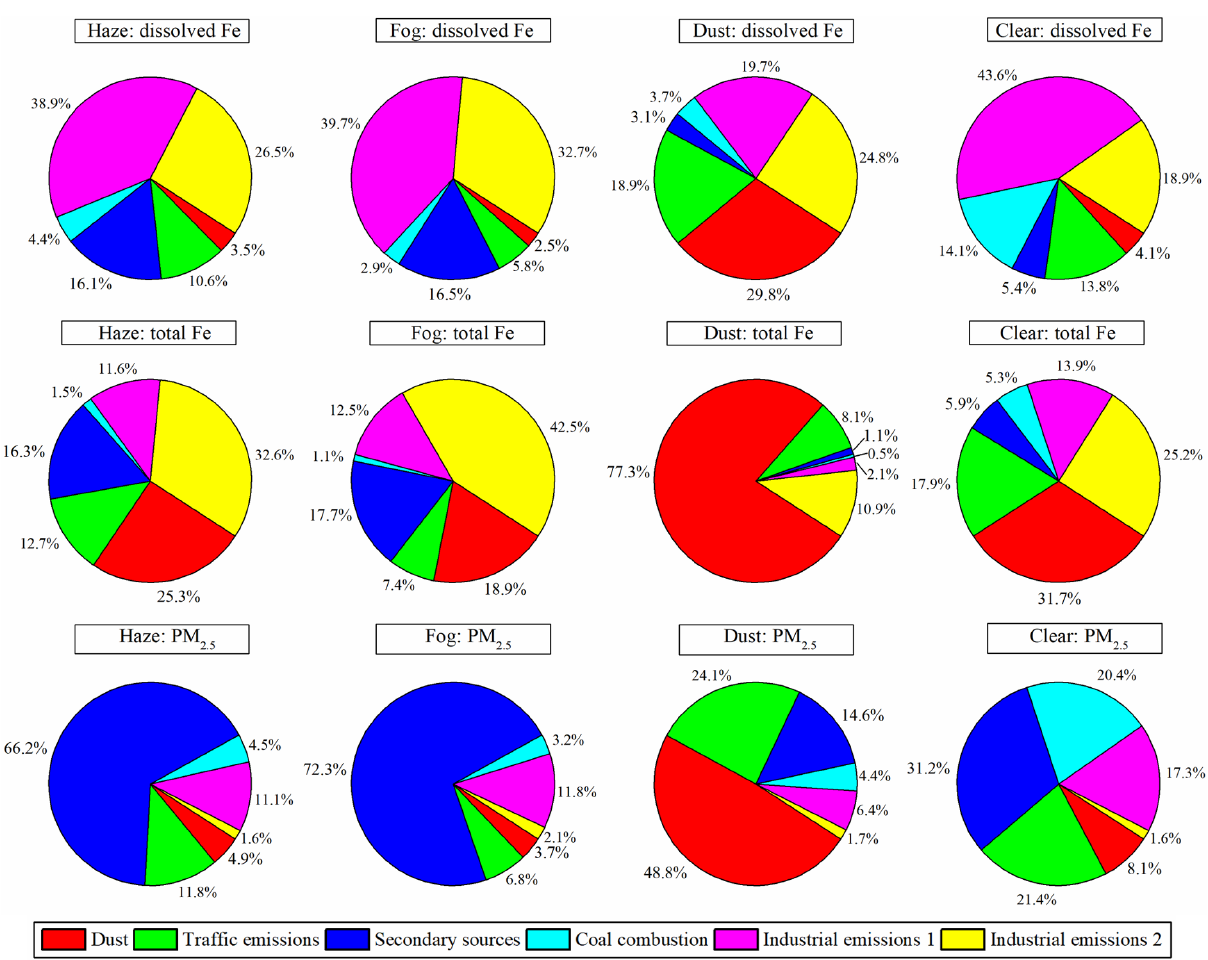
Figure 3. Contributions of identified sources to dissolved Fe, total Fe, and PM 2 . 5 on haze, fog, dust, and clear days by the PMF